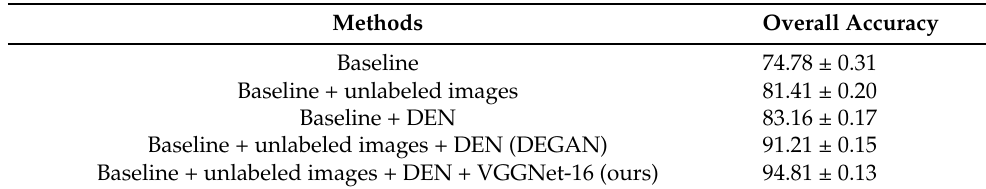
Table 2. Overall accuracy and standard deviations (%) of the GAN without DEN and DEGAN on the NWPU-RESISC45 dataset under the training ratio of